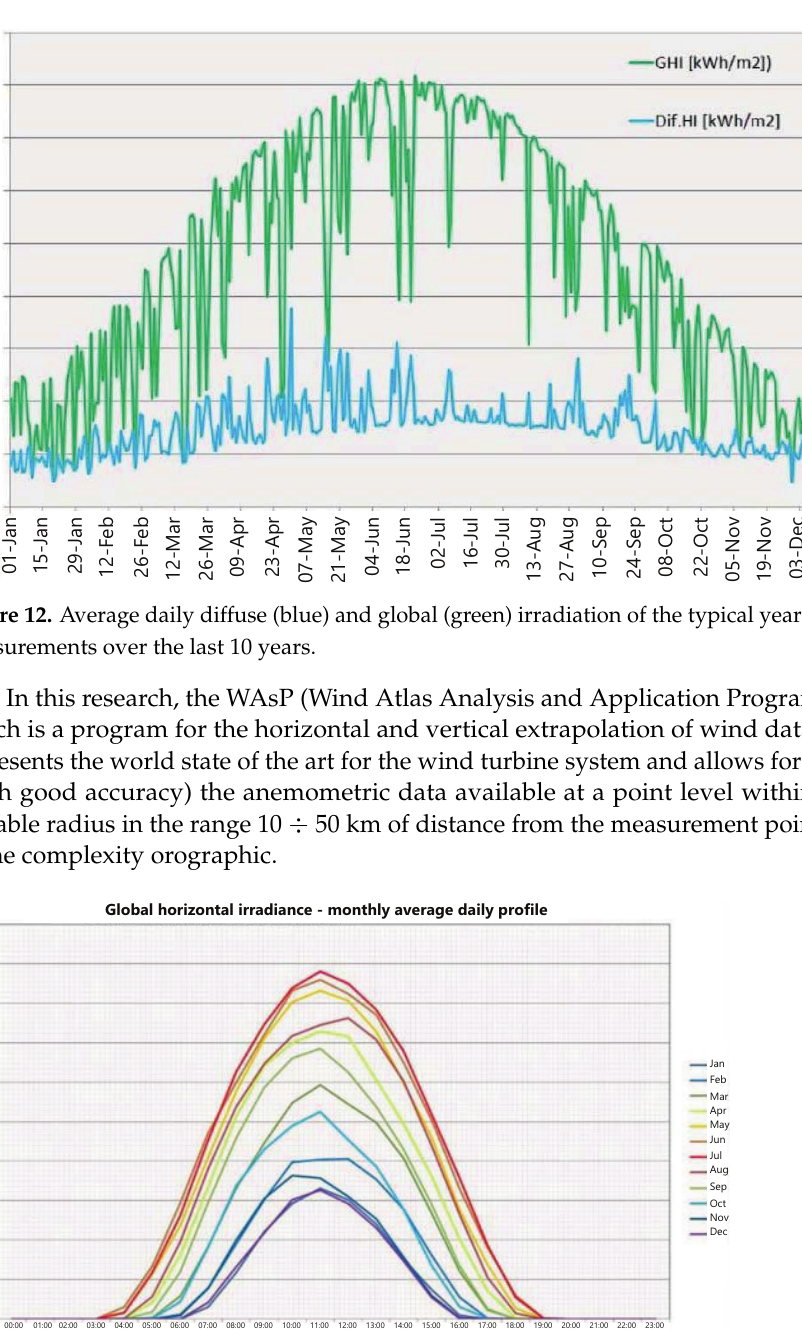
Figure 13. Average hourly horizontal global irradiation in the typical 12-day average